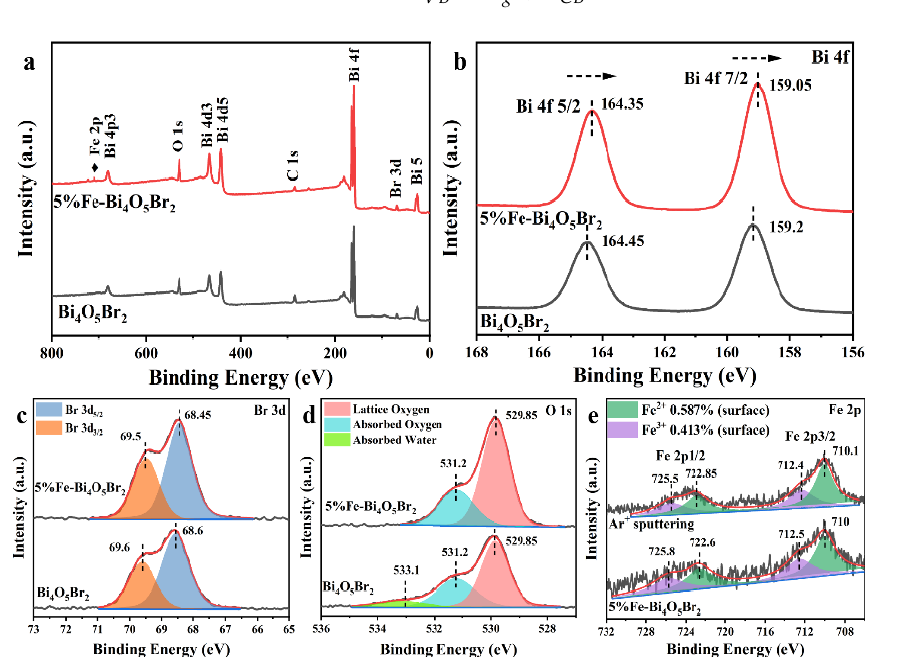
Figure 4. Binding energy of 5%Fe-Bi 4 O 5 Br 2 and Bi 4 O 5 Br 2. ( a ) High-resolution XPS, ( b ) Bi 4f, ( c ) Br 3d, ( d ) O 1s spectrum of 5%Fe-Bi 4 O 5 Br 2 and Bi 4 O 5 Br 2 and ( e ) Fe2p spectrum of 5%Fe-Bi 4 O 5 Br 2 .